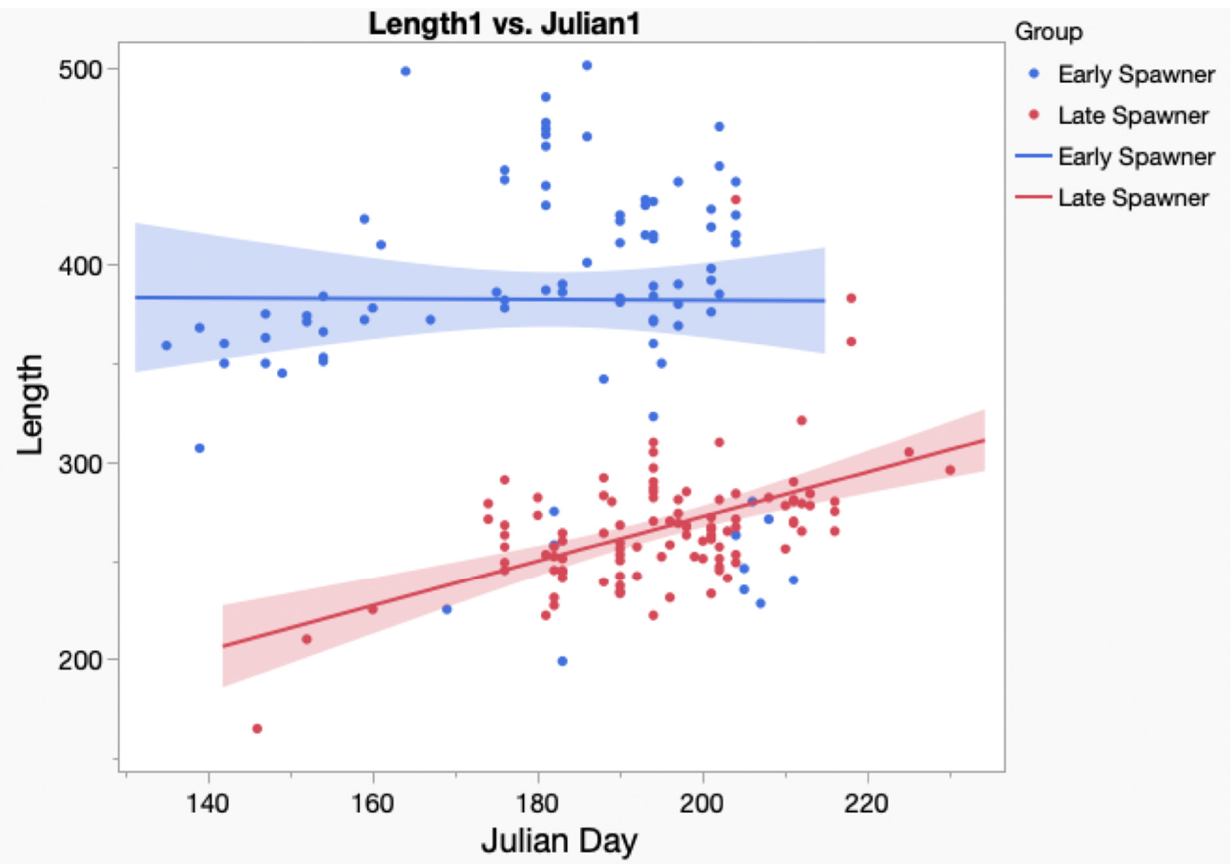
Figure 6. A plot of the length versus the Julian day of 199 1-year-old Atlantic sturgeon juveniles that were collected from the Ogeechee River between 2007 and 2017.